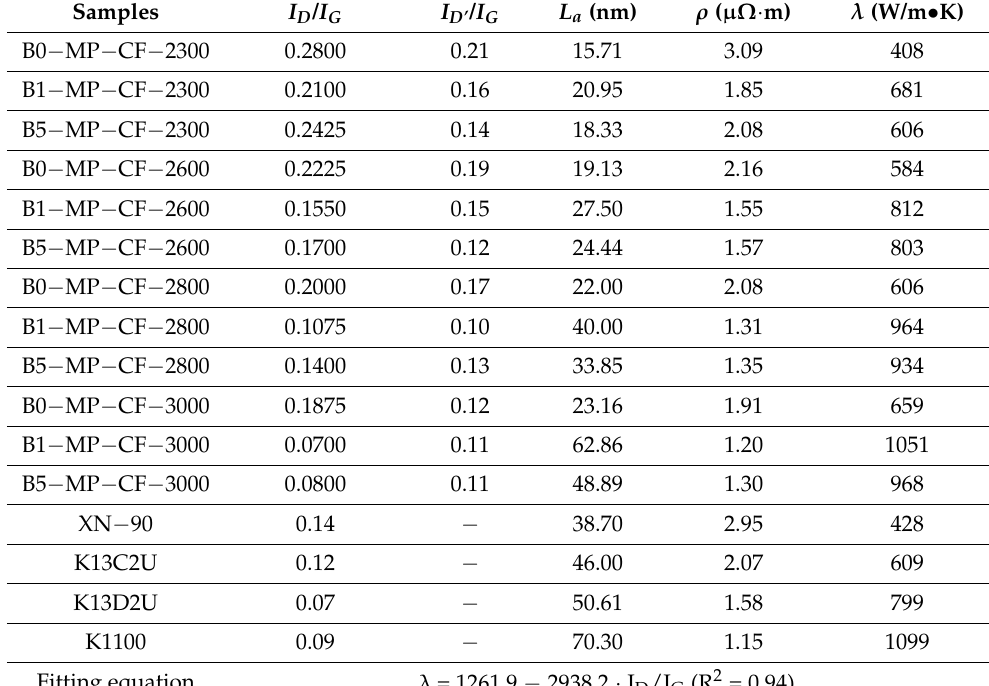
Table 2. Microcrystalline parameters and electrothermal properties of CFs.